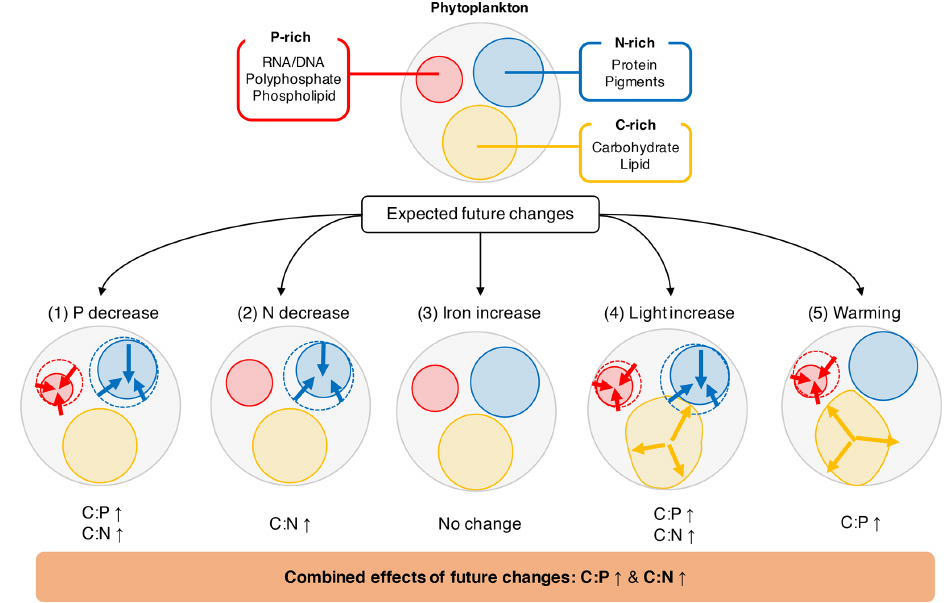
Figure 4. Illustration of how the five environmental drivers under a typical future climate scenario affect the cellular allocation of volume between P-rich (red), N-rich (blue), and C-rich (orange) pools. The values for projected changes in C : P and C : N between 1981–2000 and 2081–2100 are given in Table